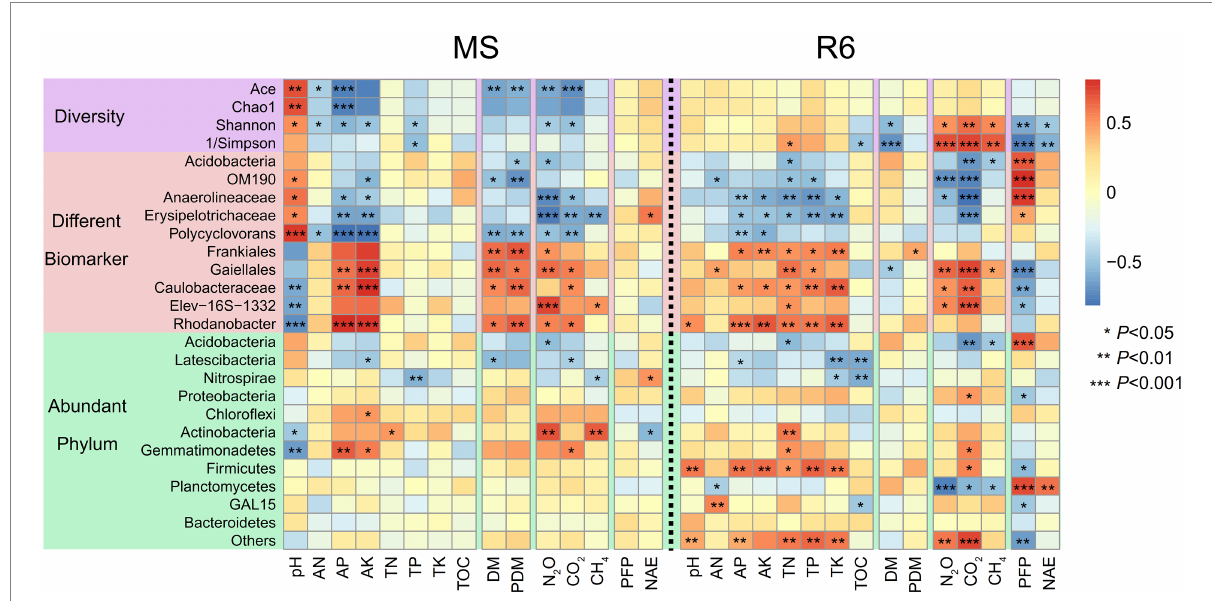
FIGURE 6 Spearman correlation heat maps of environmental factors and bacterial diversity, different biomarkers, and abundant phylum. Red represents a positive correlation, and blue represents a negative correlation (* p < 0.05; ** p < 0.01; *** p < 0.001). MS, maturity stage of wheat; R6, maturity stage of wheat; DM, dry matter of crop; PDM, population dry matter of crop; PFP, N partial factor productivity; NAE, N agronomic efficiency; TOC, soil total organic carbon; TN, total nitrogen; AN, alkali-hydrolyzed nitrogen; TP, total phosphorus, AP, available phosphorus, TK, total potassium, AK, available